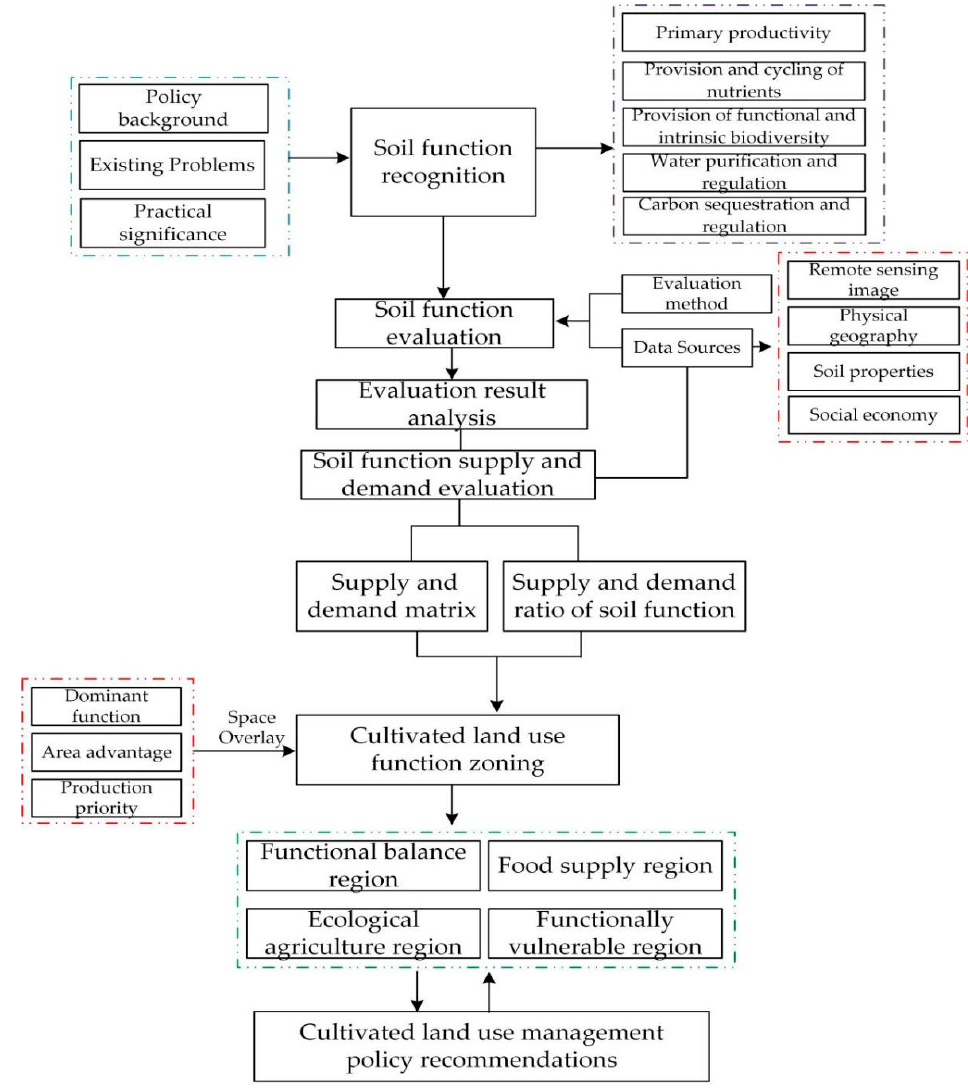
Figure 1. The research frame diagram.